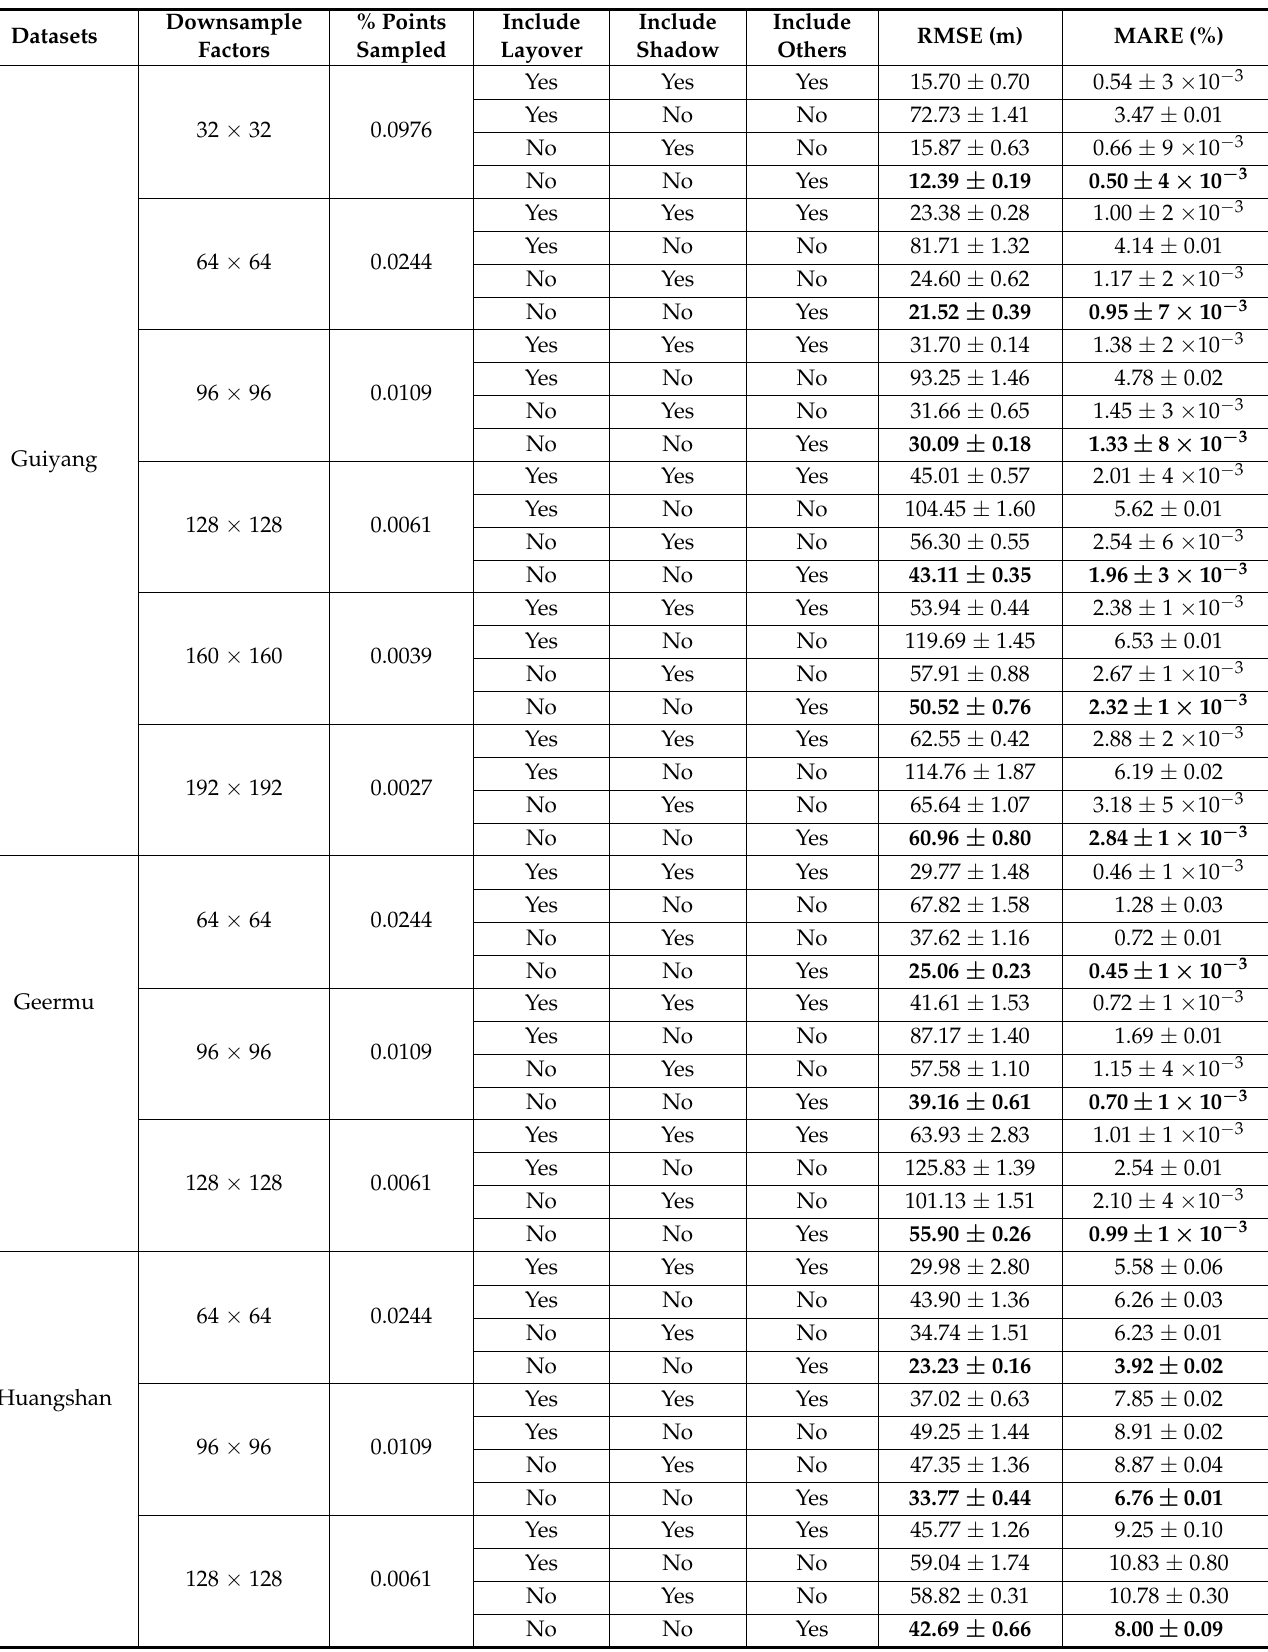
Table 5. Comparison experiments on the layover and shadow areas on the three